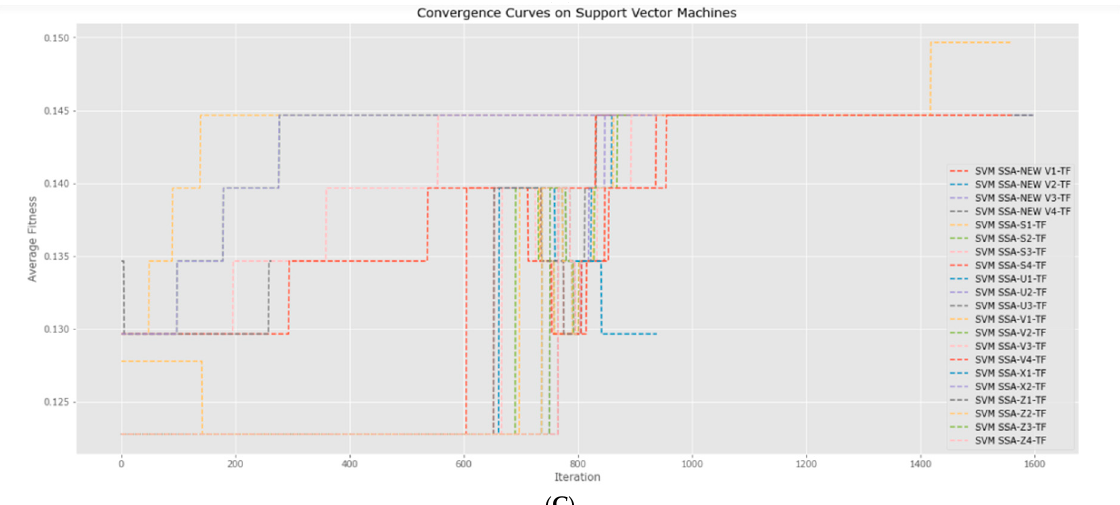
Figure A1. The average fitness results obtained were based on the convergence curve for the SSA-TF algorithm using the KNN ( A ), naive Bayes ( B ) and SVM ( C ) algorithms.